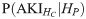
Feature extraction pipeline for estimating P(AKI) during rehospitalization.We sought to estimate the probability of AKI during rehospitalization given all of a patient’s previous hospitalizations, P(AKIHC|HP)), shown by the red arrow. An example of three hospitalizations (H1, H2, H3) is shown. Here H1 and H2 are used to estimate P(AKI) during H3. The EHR captures raw data (shown in boxes closest to the time series tracings) of which our dataset contains N + 1 features. At each level, data is aggregated via domain-expertise-informed functions F and G. The pipeline produces a single, fixed-length representation of all previous hospitalizations to serve as input to a learning algorithm. Measurements from each hospitalization, and series of hospitalizations, are treated as sequences, denoted with operator s.